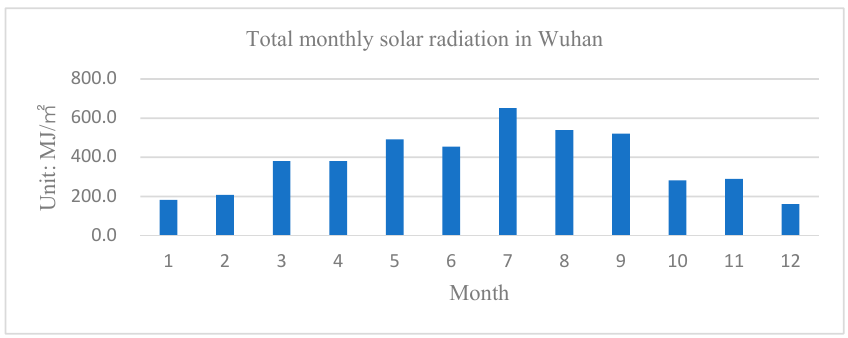
Figure 5. Total monthly solar radiation in Wuhan [31].